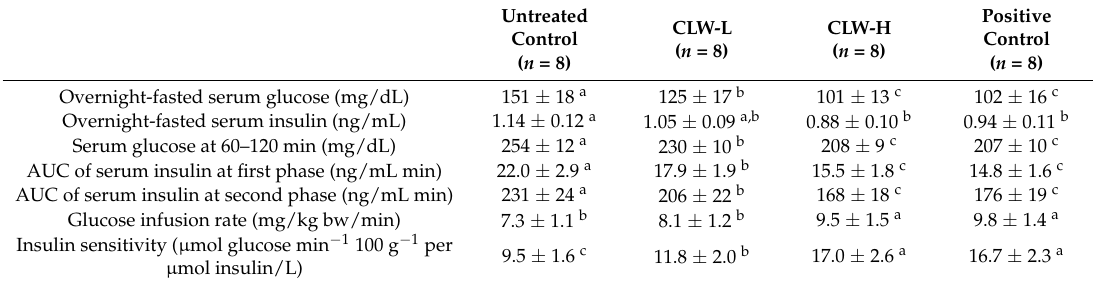
Table 2. Insulin secretion capacity during the hyperglycemic clamp.